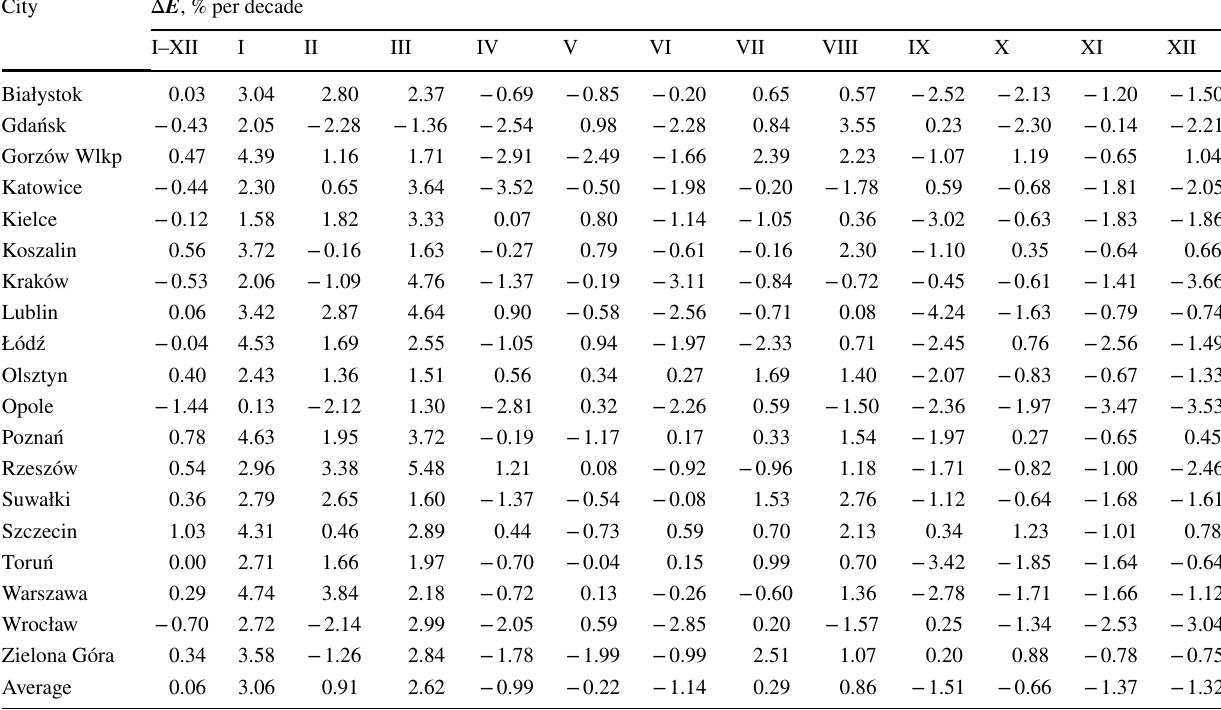
Table 3 Trends of change of water saving efficiency (% per decade) City